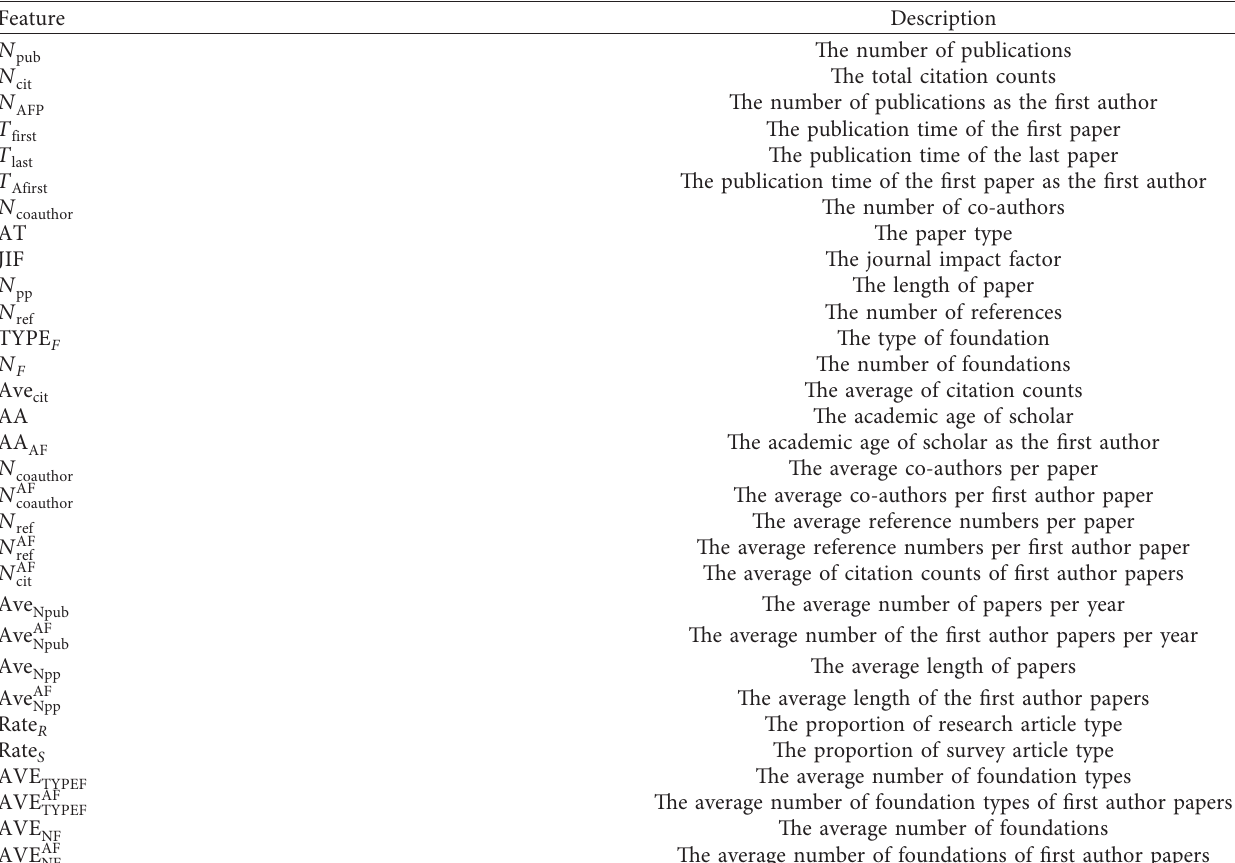
Table 1: Intuitive factor